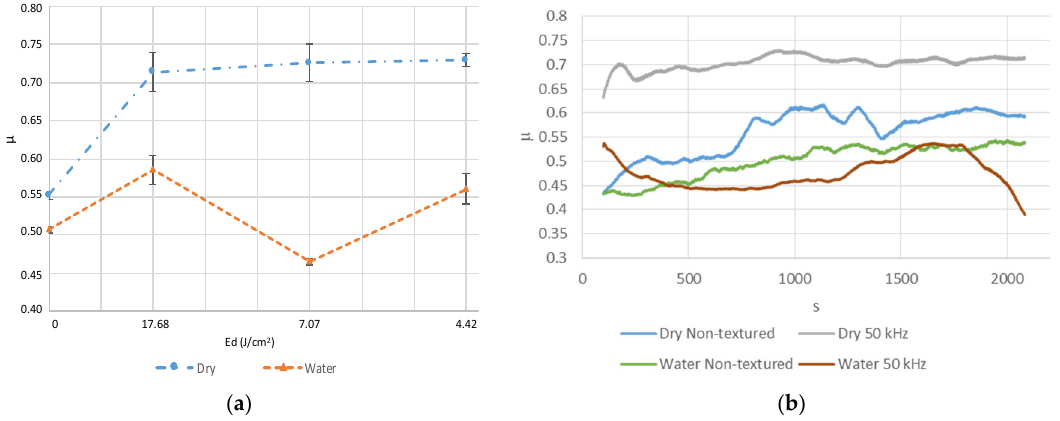
Figure 16. ( a ) Friction coefficient as a function of E d in V s = 10 mm s −1 for wet and dry conditions tests; ( b ) Friction coefficient as a function of time for wet and dry conditions tests for E d = 7.07 J cm −2 and V s = 10 mm s −1 laser treatment.